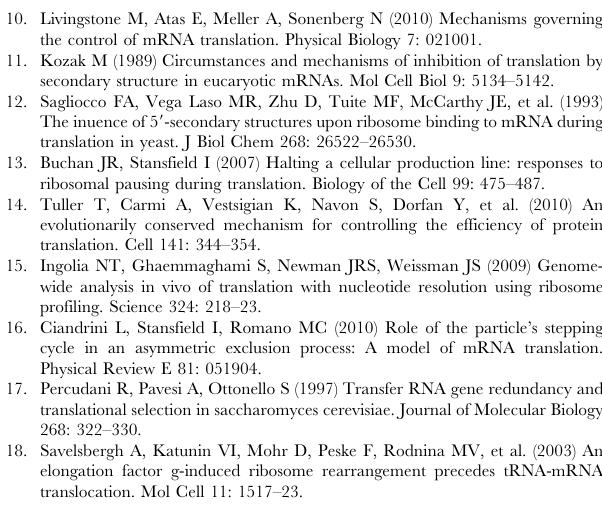
Figure 2. Each sheet is named with the corresponding region (i)– (iv) of Figure 3, and with the GO aspect (process, function, component). Table S3 GO annotations of genes found in the smooth, abrupt and hybrid classes. Each sheet is named with the sequence type (smooth, abrupt, hybrid), and with the GO aspect (process, function, component).